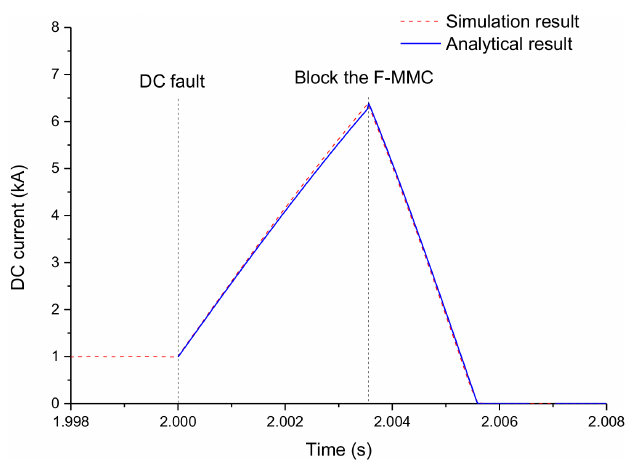
Figure 15. DC current of MMC with solution 2 when AC system is not considered.